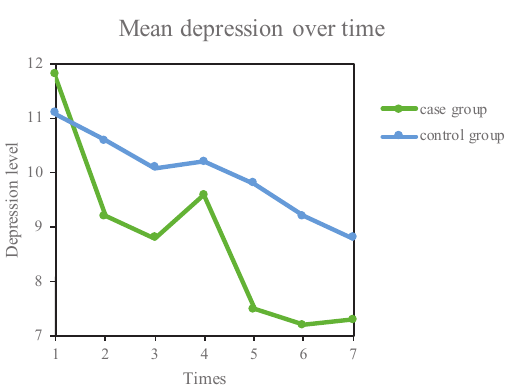
Figure 3. Time trend of mean anxiety in the intervention and control